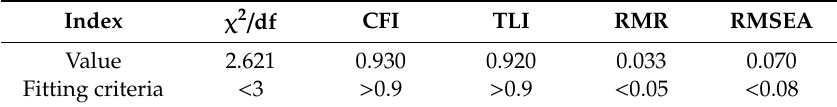
Table 2. Proposed model fitting index